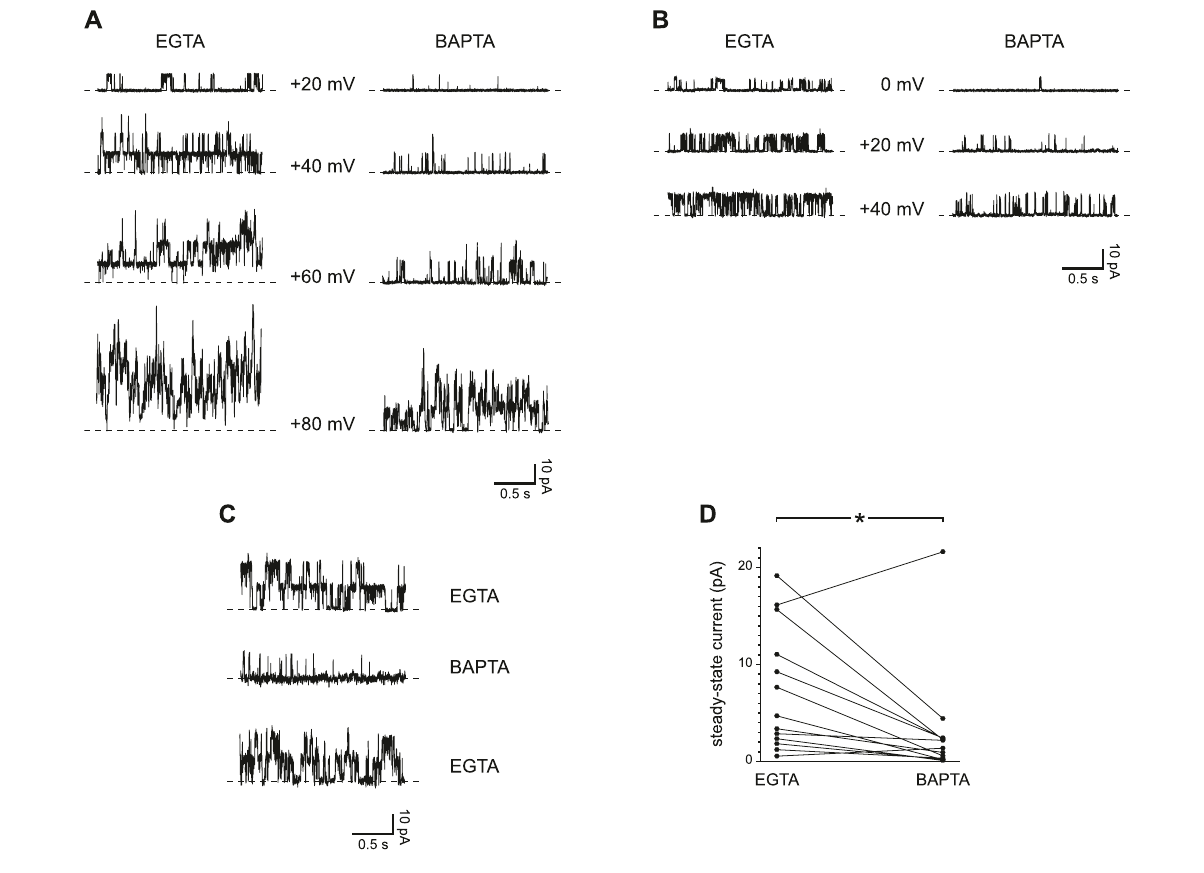
Frontiers in Physiology |